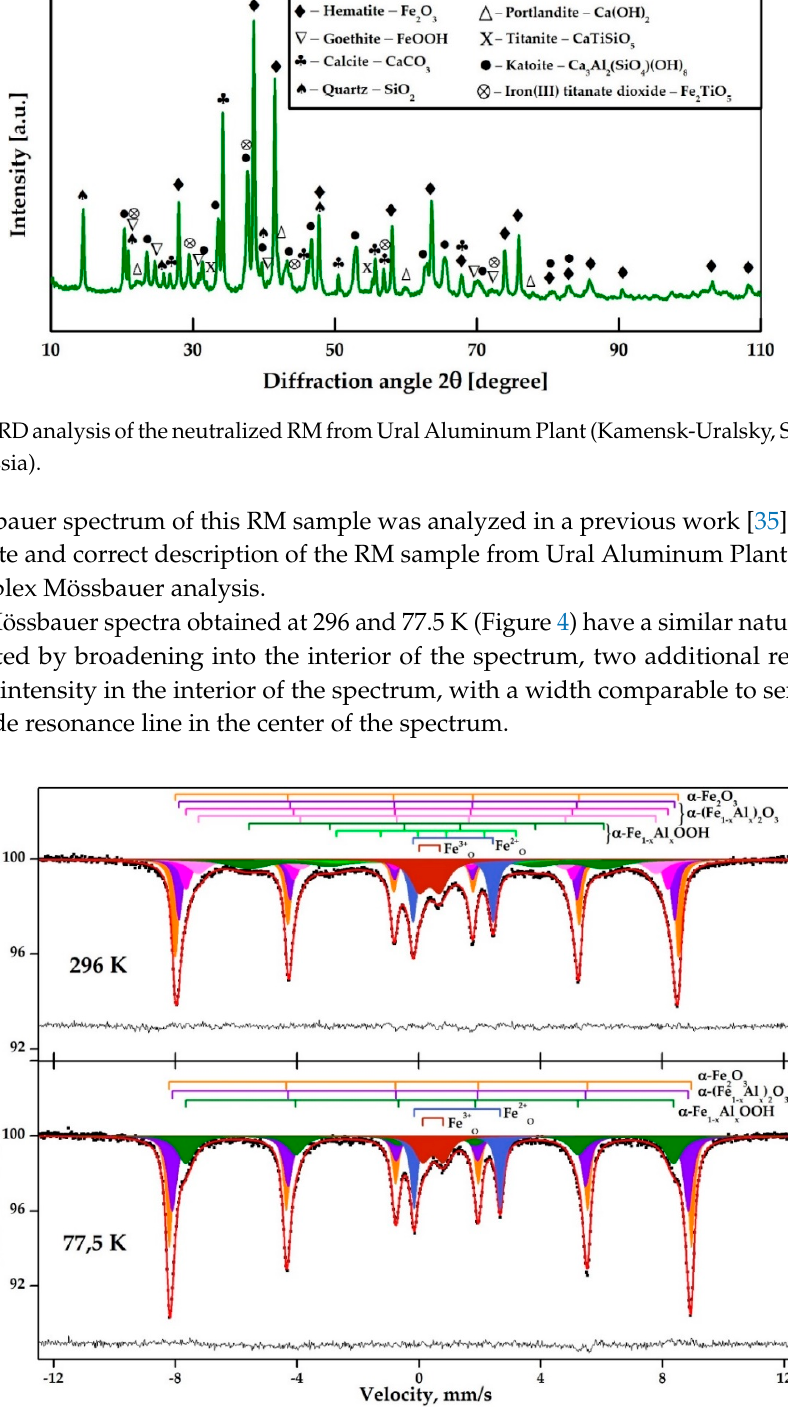
Figure 4. Mössbauer spectra of the RM sample obtained at 296 and 77.5 K.